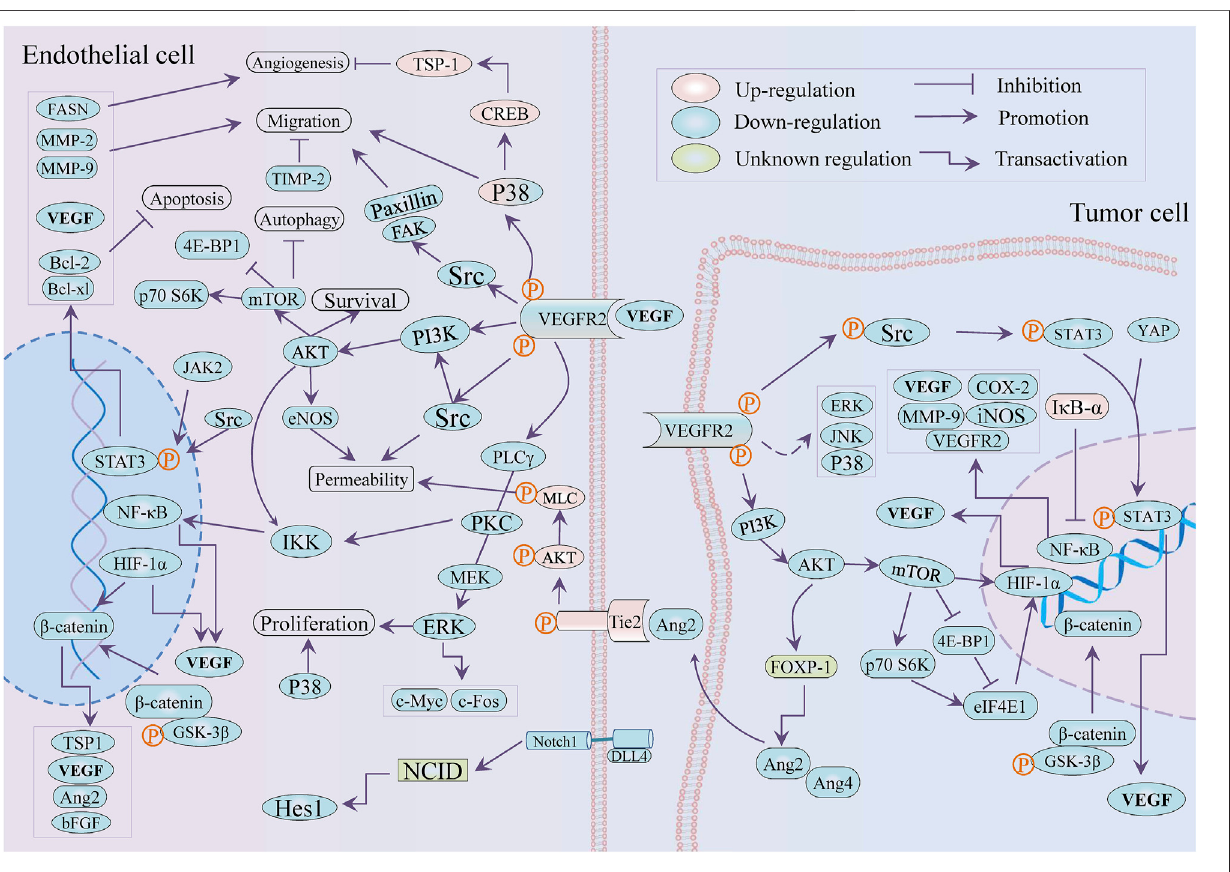
Frontiers in Pharmacology |